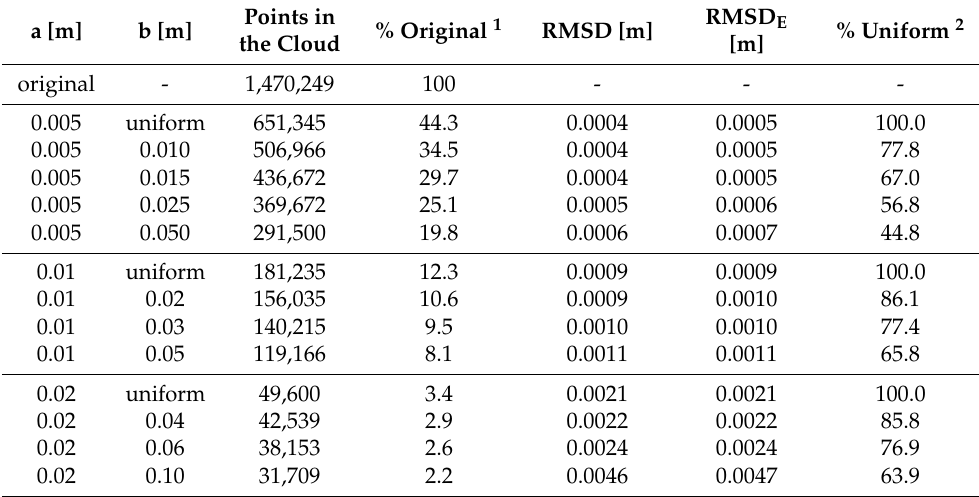
Figure 11. Data 3—examples of dilution: a = 0.005 m in all cases; ( a ) uniform dilution; ( b ) b = 0.010 m; ( c ) b = 0.025 m; ( d ) b = 0.050 m. Table 4. Results of dilution of the Data 3 cloud—numbers of points and RMSDs (R = 0.05